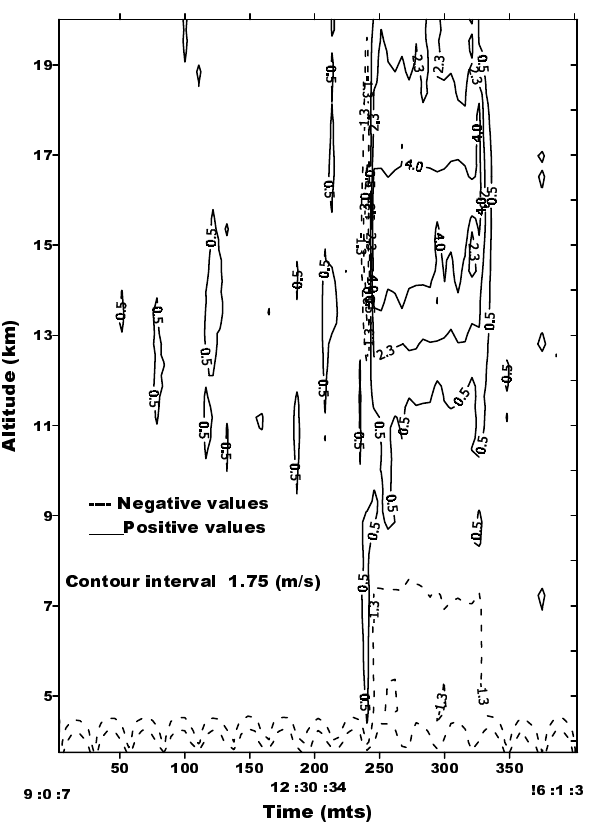
Fig. 3. Zonal wind shear on 28 August 1999, 09:00 to 16:00LT. The full line indicates positive shear and dashed line indicates negative shear. Contour interval is 0.07s − 1